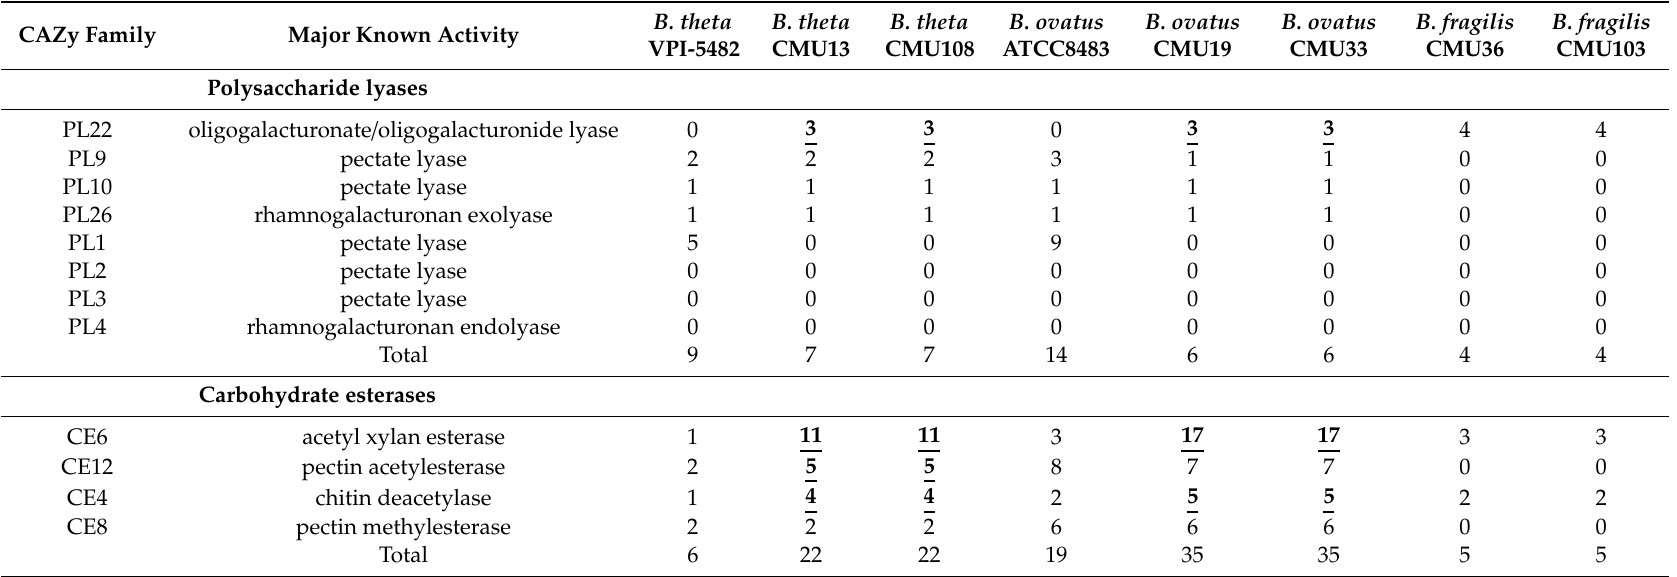
Table 4. CAZome of bacterial isolates for the major carbohydrate esterase (CE) and polysaccharide lyase (PL) families involved in degradation of plant cell walls. CAZy